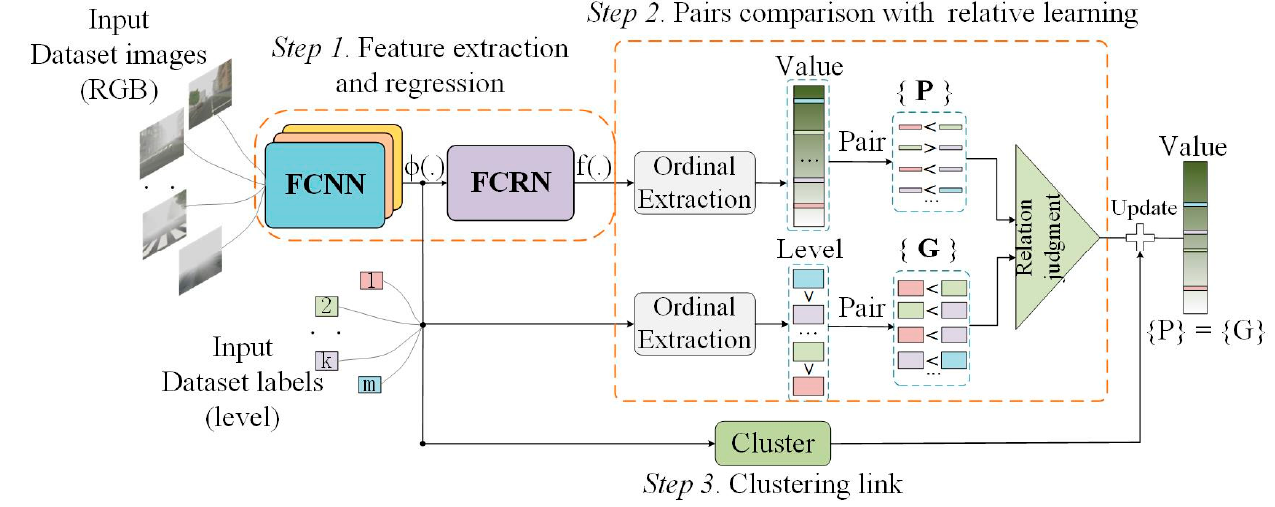
Figure 2. Schematic diagram of the proposed VISOR-NET with batch images.